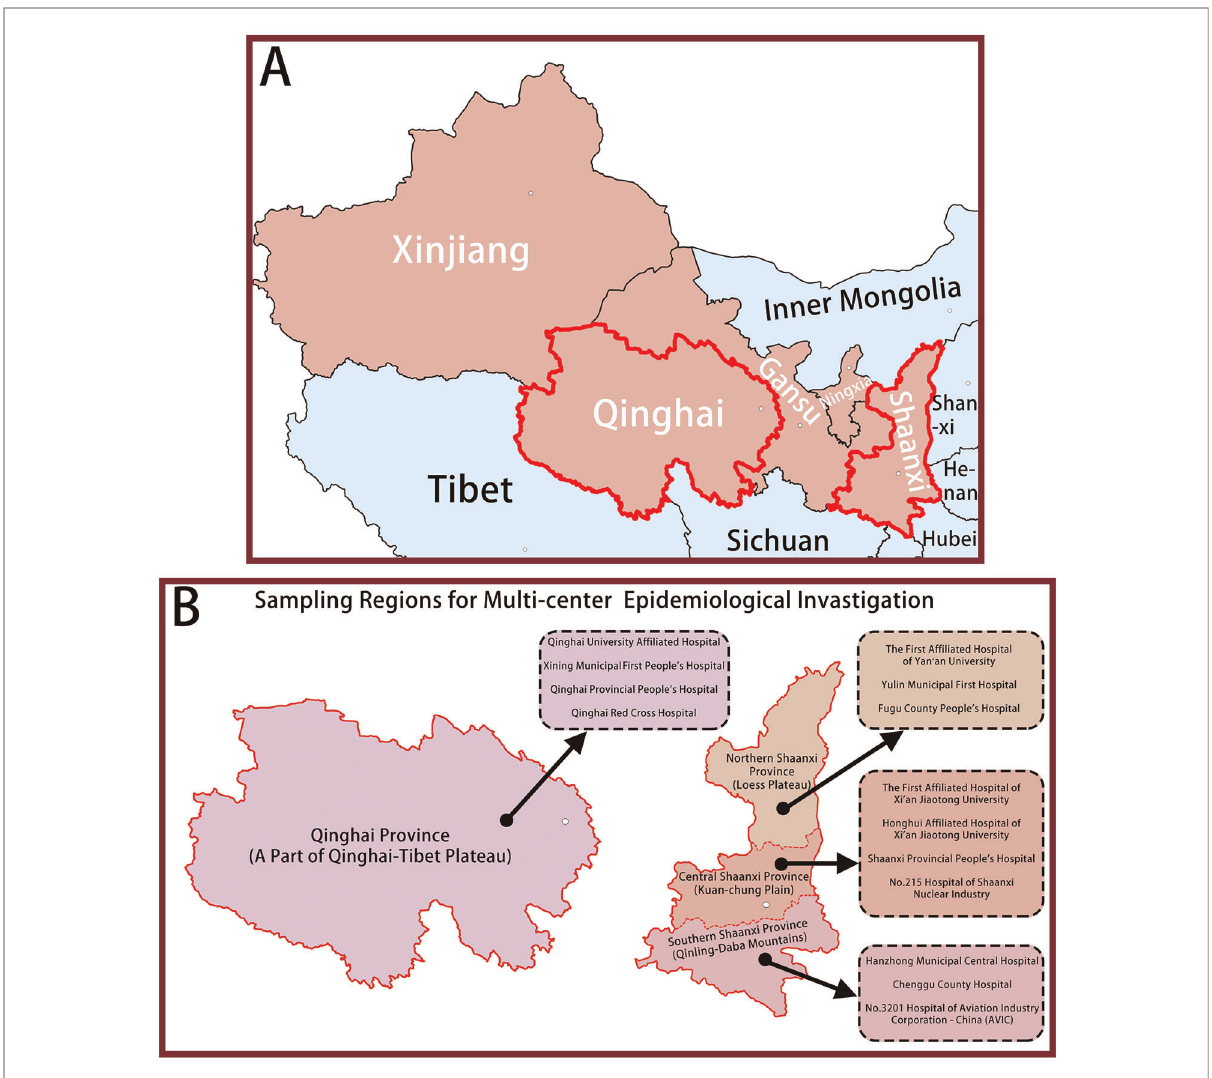
FIGURE 1 A total of 2621 patients form 14 hospitals in two provinces with TSCI were identi fi ed in this study ( A ) Sampling Provinces; ( B ) Sampling Regions for Multi-center Epidemiological